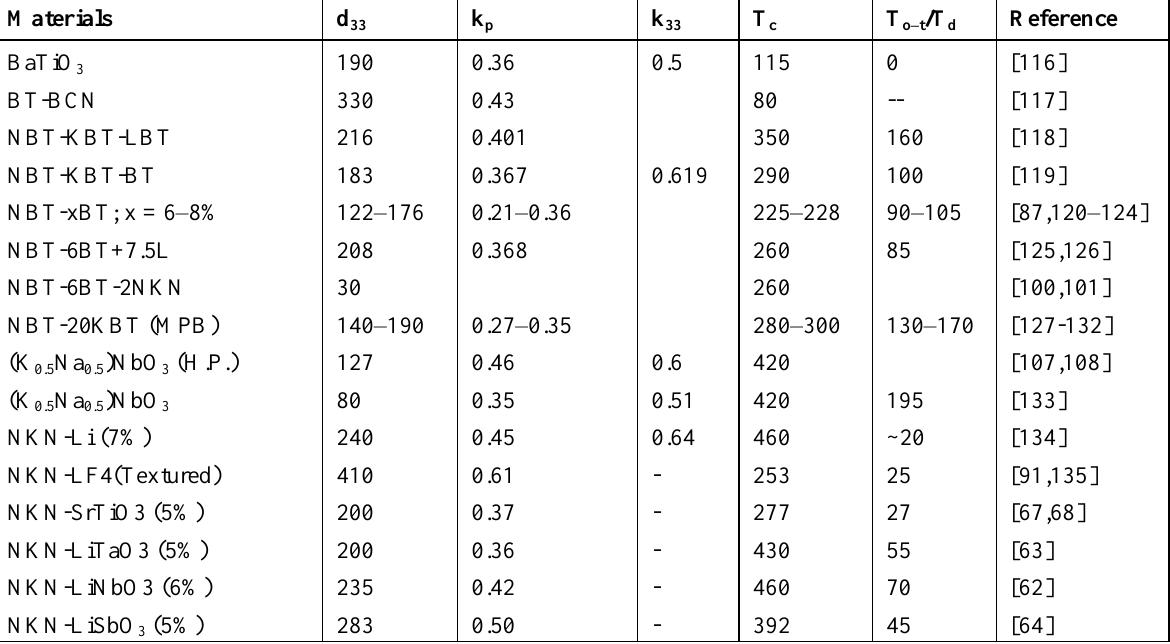
Table 1. Dielectric and piezoelectric properties of the prominent lead-free systems.